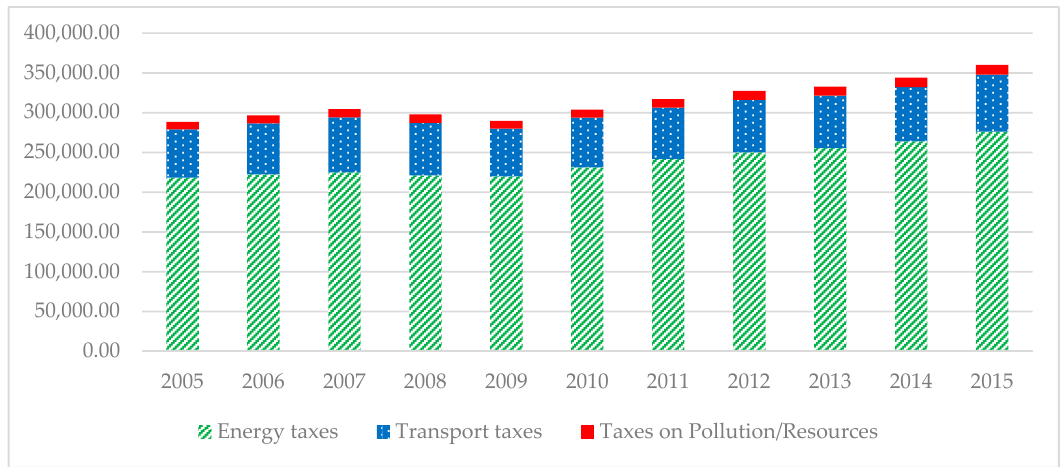
Figure 1. Environmental tax revenue by type of tax in the 28 European Union (EU) countries, Million euro.